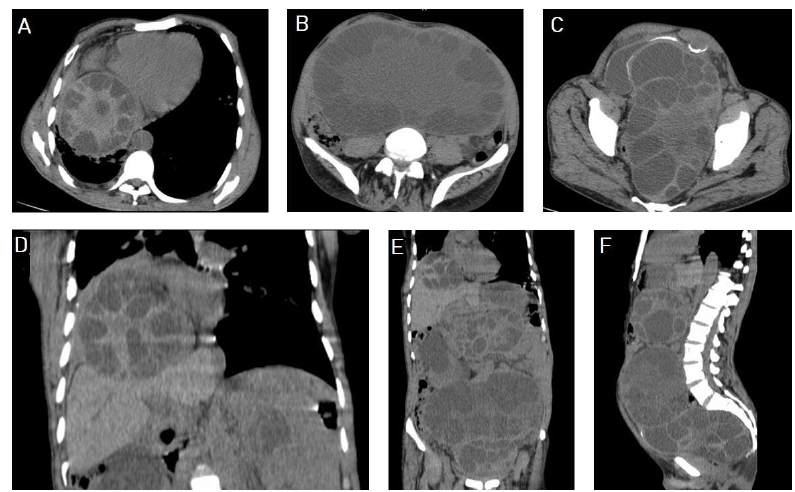
Figure 17. Selected CT images of a 60-year-old male with renal impairment presenting with abdominal pain and distention, showing about 8.6 × 8.2 cm hydatid cyst with multiple daughter cysts in the lower lobe of the right lung, indenting the right hemidiaphragm, and compressing the lower liver seen on axial ( A ) and coronal ( D ) sections. Additionally, showing multiple abdominal and pelvic large hydatid cysts with multiple internal daughter cysts compressing bilateral ureters, causing moderate bilateral hydronephrosis, and compressing the urinary bladder anteriorly seen on axial ( B , C ), coronal ( D , E ), and sagittal ( F ) sections. Pictures from Type IIA with typical “spoke-wheel appearance” occurring on images ( A – D ).